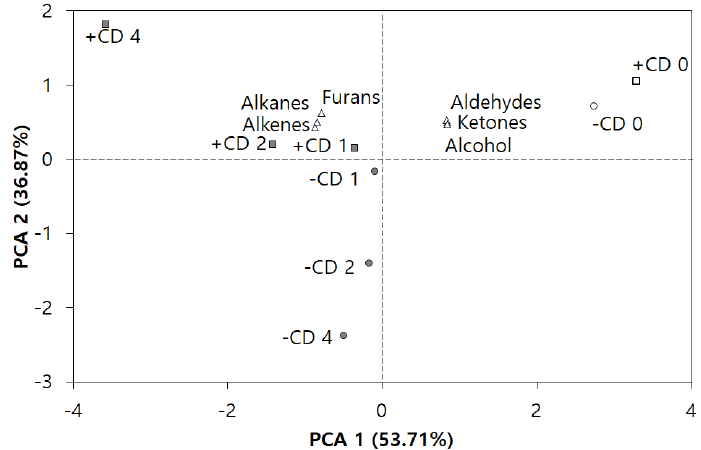
Figure 1. Principal component analysis of the volatile compound natures affected by CD concentrations (0, 1, 2, and 4) and the presence (+) or absence ( − ) of excessive flavor-entrapped CD (+CD and -CD groups) in ISP